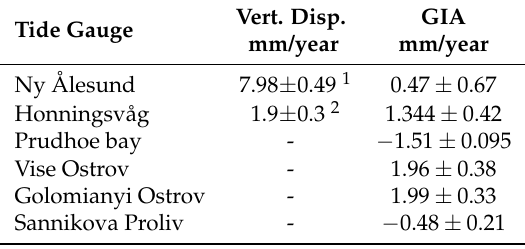
Table 4. Vertical displacement from from GPS and the Caron et al. [58] GIA model. Vert. Tide Gauge